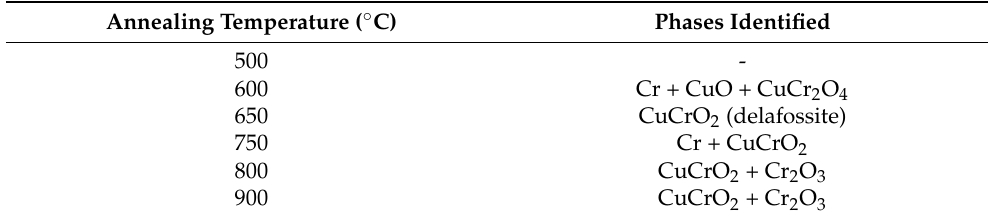
Table 3. Relation between post-deposition annealing condition and phases identified through XRD analysis.